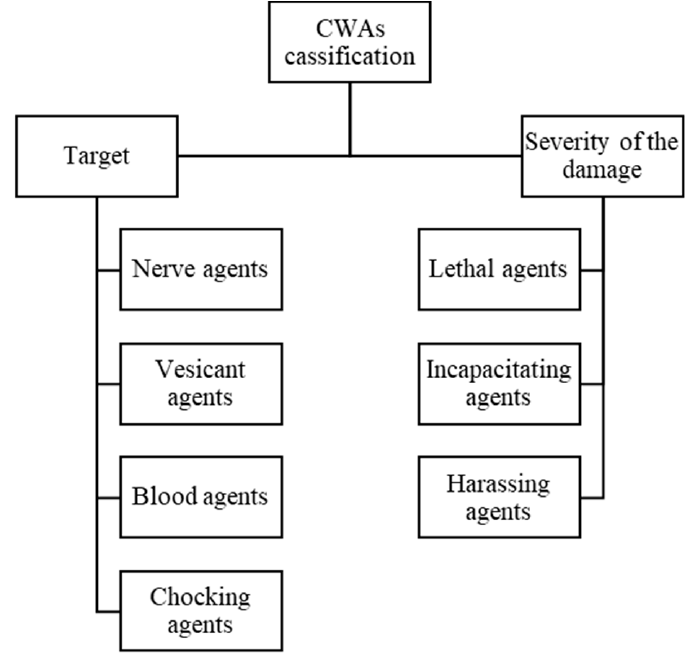
Figure 2. Classification of CWAs depending on their target and the severity of the damage. Blood agents: are mainly cyanides and cause symptoms like choking of breath, vomit- ing blood, between others [19]. These compounds release cyanine ions in the organism and disturb the typical functions of the body, preventing the normal consumption of oxygen by the body tissues. The main agents in this category are hydrogen cyanide (HCN) and cyanogen chloride (CNCl)